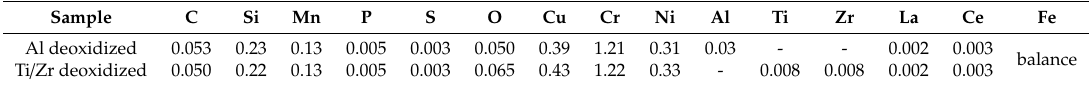
Table 1. Chemical compositions of the RE microalloyed steels